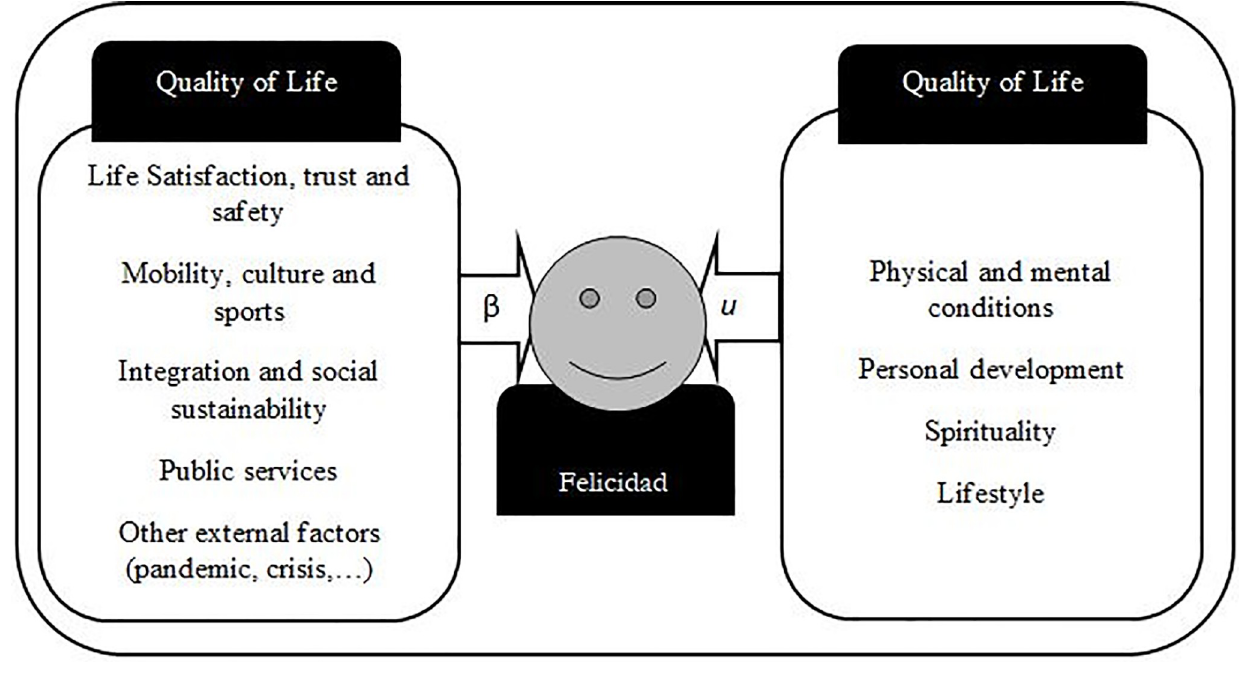
Fig 1. Happiness model